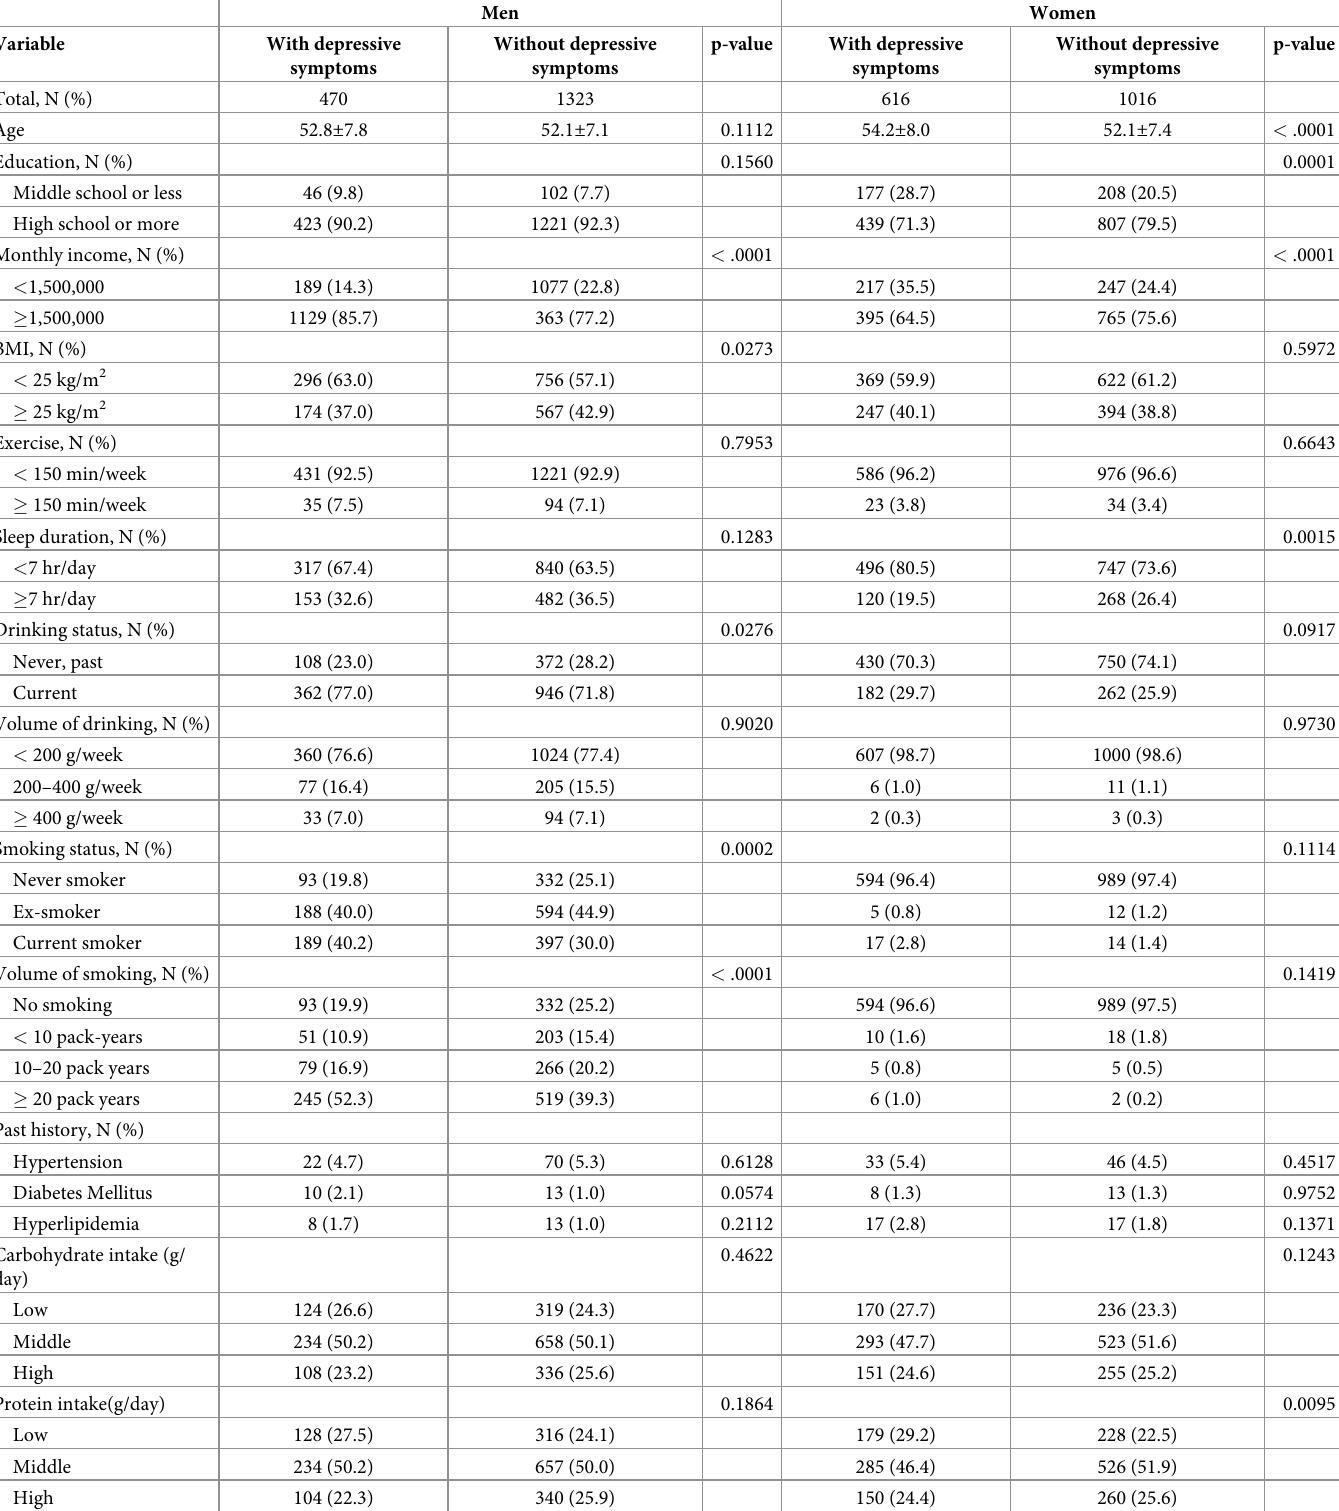
Table 2. Sociodemographic characteristics of subjects with and without depressive